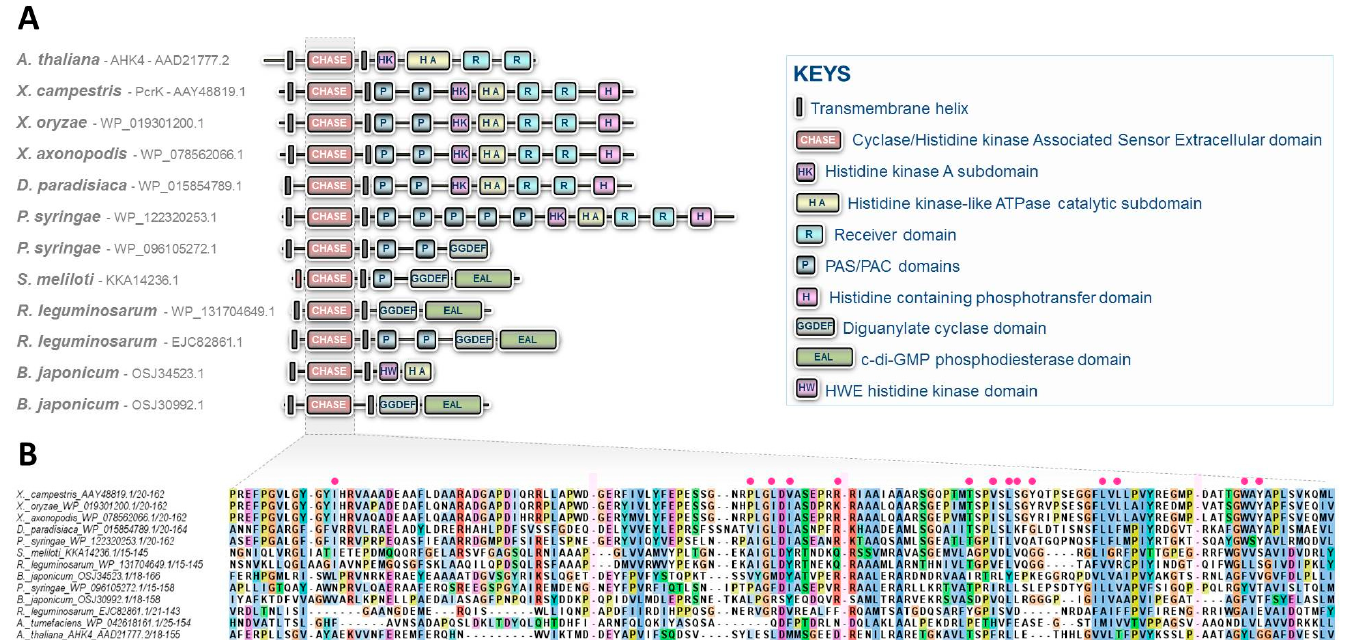
Figure 2. CHASE domain-containing proteins predicted in some prominent plant pathogenic or symbiotic bacteria. ( A ) Diversity of structures found in various plant interacting bacterial species including the recently characterized CK receptor, PcrK in Xanthomonas. The structure of the Arabidopsis CK receptor AHK4 is also provided for comparison. No CHASE domain-containing proteins are predicted in Ralstonia solanacearum, Erwinia amylovora, Xylella fastidiosa, Pectobacterium sp., Rhodococcus fascians , and Spiroplasma sp. ( B ) Alignment of CHASE domains from these predicted bacterial proteins. Interruptions of the alignment are indicated by pink rectangles, and essential residues reported to be involved in the binding pocket of Xanthomonas PcrK are indicated with red circles